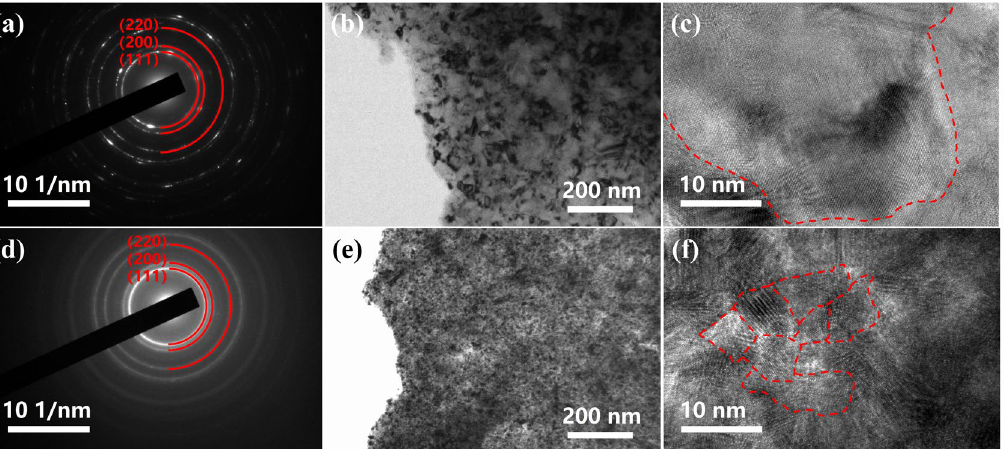
Figure 4. TEM characterization. ( a ) SAED pattern, ( b ) TEM image, ( c ) HRTEM image of Ni/SDS-SiC coating prepared at the current density of 2.0 A dm −2 ; ( d ) SAED pattern, ( e ) TEM image, ( f ) HRTEM image of Ni/binary - SiC coating prepared at the current density of 2.0 A dm −2 .